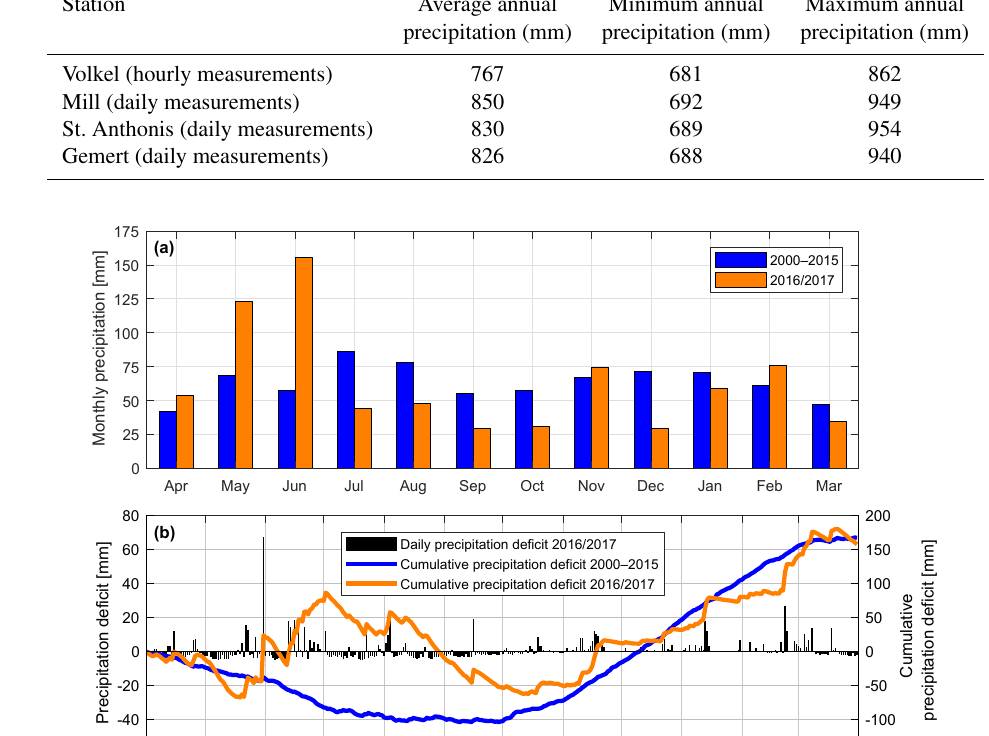
Table 1. Precipitation statistics of the KNMI weather and precipitation stations for the period 2000–2016 (KNMI, 2017). Station